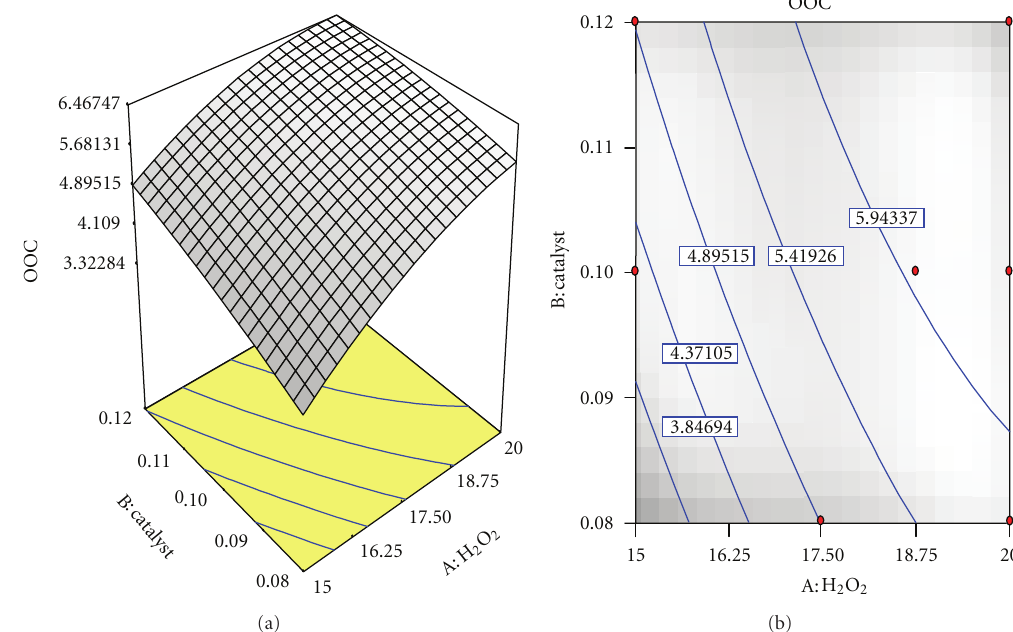
Figure 4: Response surface (a) and contour plots (b) for the e ff ect of the H 2 O 2 ( X 1 , μ L) and catalysts Novozym 435 ( X 2 , mg) on the OOC% of MEOA.